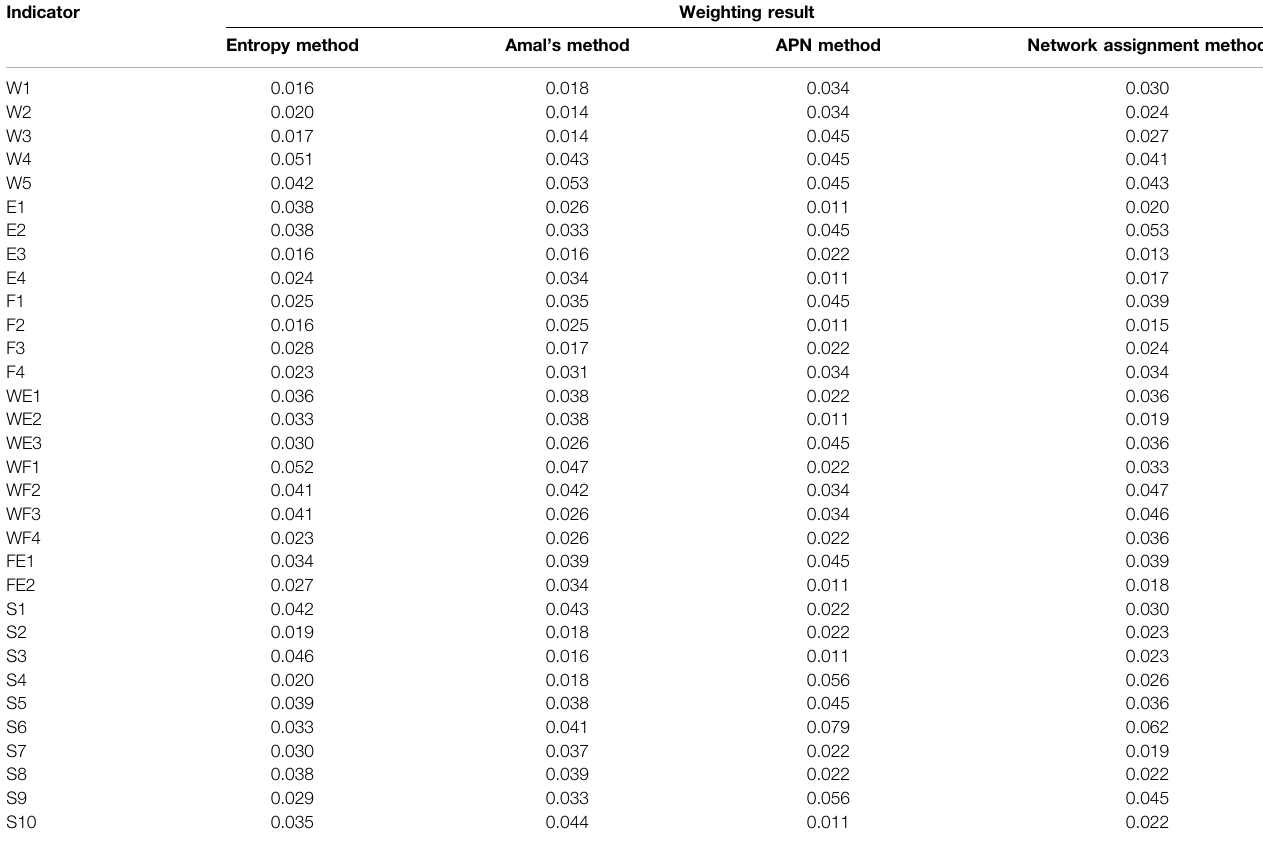
TABLE 3 | Comparison of indicator weight results calculated by different methods.